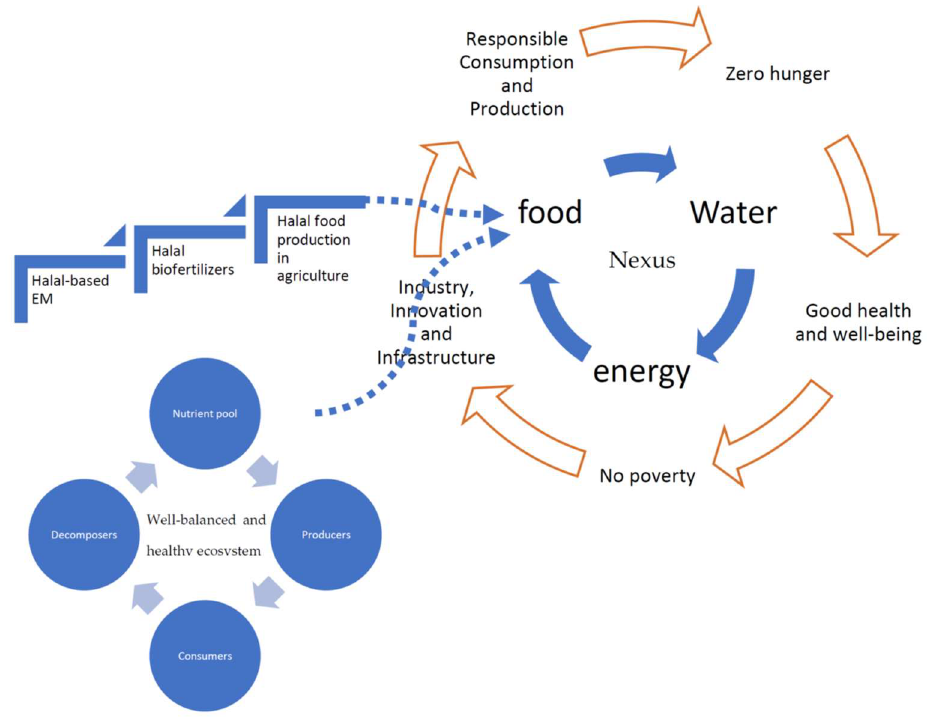
Figure 3. Connections of Halal -based sources for biofertilizer production for overall food chain supply for the food–water–energy Nexus.